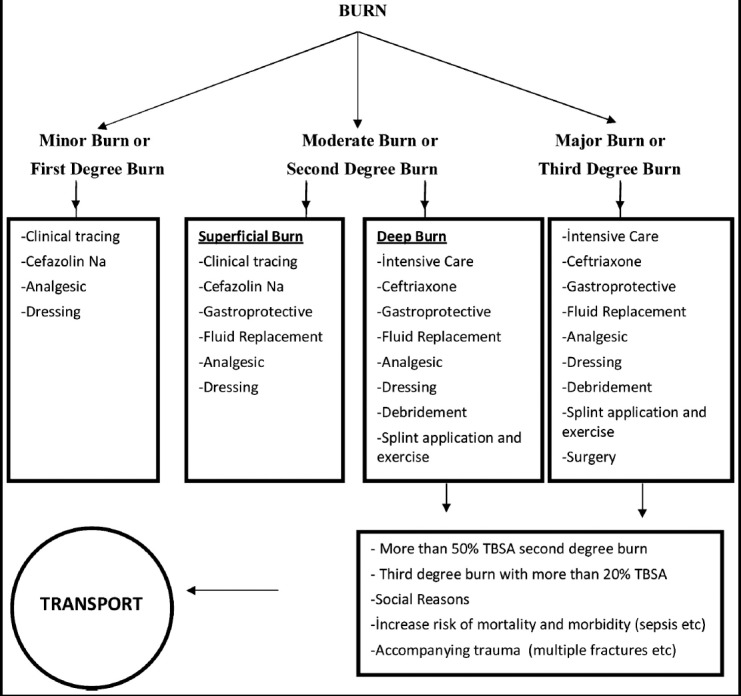
Treatment algorithm according to burn degree and the percentage.Classification of Burn Percentage:.Minor Burns According to TBSA.*First degree child burns*Second degree child burns less than 10% TBSAModerate Burns According to TBSA.*Second degree child burns involving 10 to 30% TBSA*Third degree child burns less than 10% TBSAMajor Burns According to TBSA.*In children, second degree burns greater than 30% TBSA*Third degree child burns greater than 10%* Burns of the eye, ear, face, hand, foot, and genitalia.